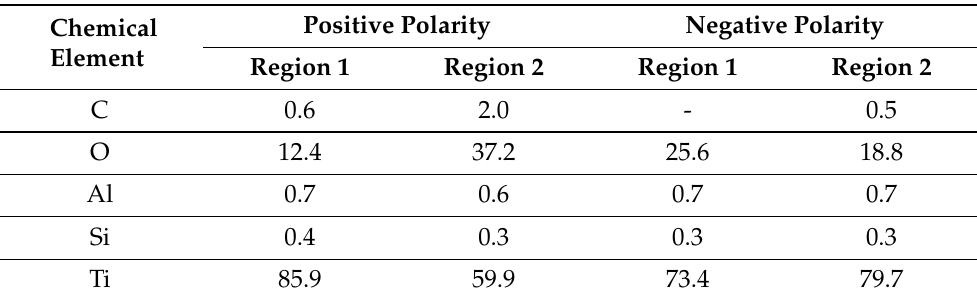
Figure 9. Concentric electrodes after the test with the positive ( a ) and negative ( b ) polarity of the SP pulses. Table 2. Chemical composition of the concentric electrodes after the test with the positive and negative polarity of SP pulses. EDX analysis is performed at the regions marked by the white points in Figure